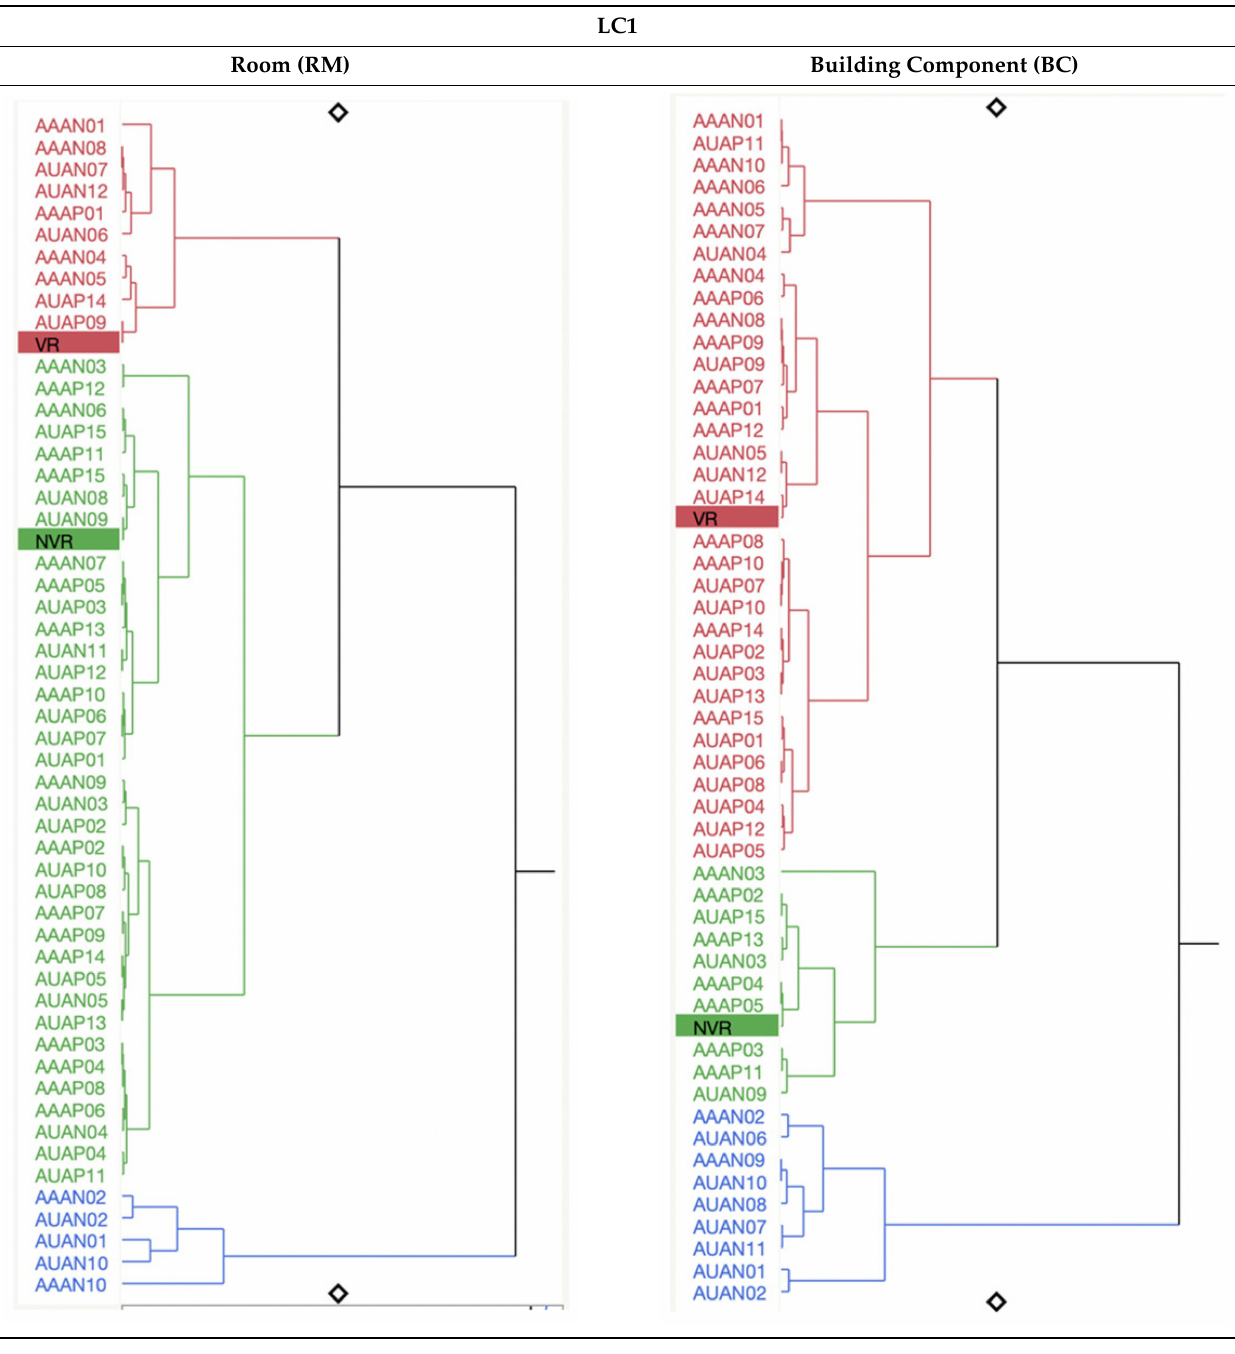
Table 13. Dendrograms of hierarchical analysis method between affordances and media in